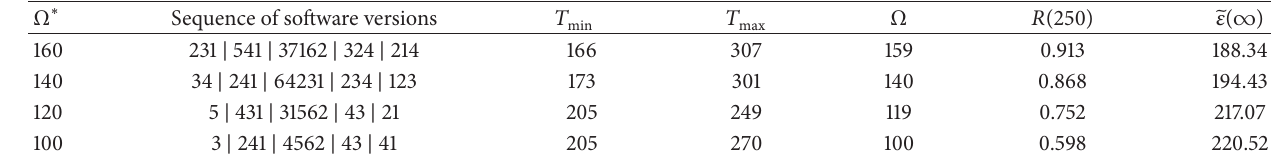
Table 2: Parameters of solutions obtained for 𝑤 = 250